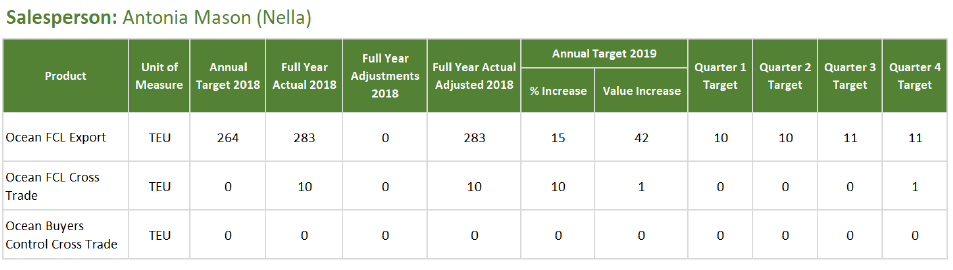
Figure 3. Example of target setting in Incentive Management System.